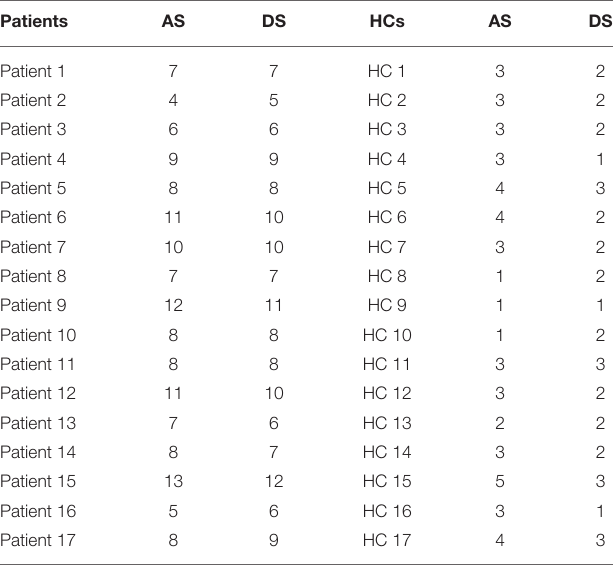
TABLE 3 | The results of the HADS test in patients with MMD and